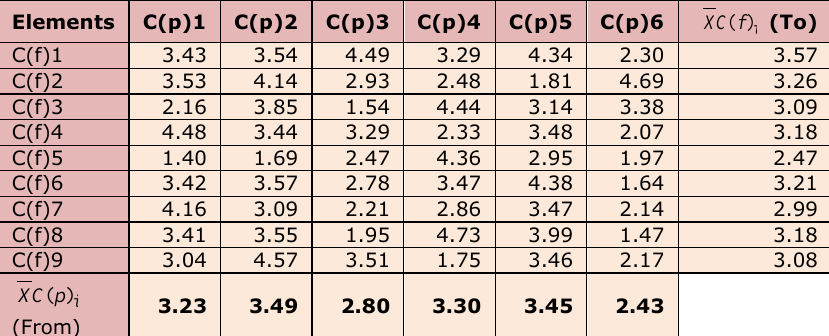
Table 3. Associations Matrix summary for the electronic tour guide design study